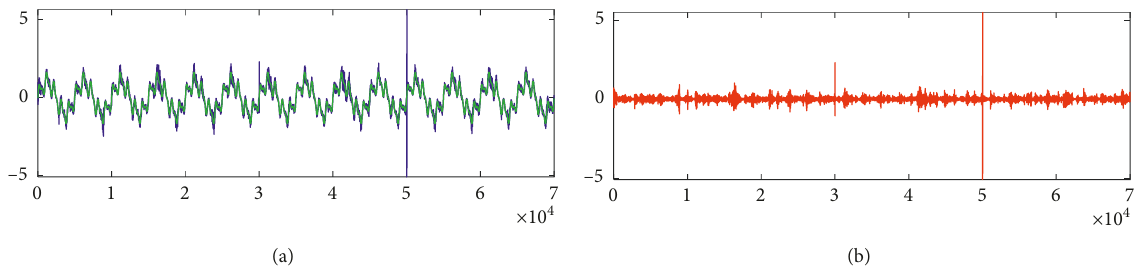
Figure 9: The residual noise of the NLMS algorithm with signal mutation. (a) Signal and e